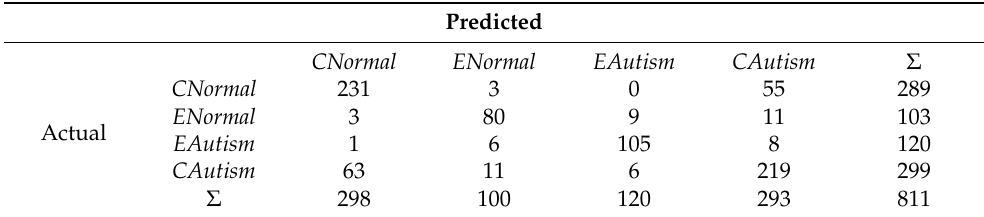
Table 13. Confusion matrix from Exp-4 (model trained and tested with the combined dataset with additional race group labels).